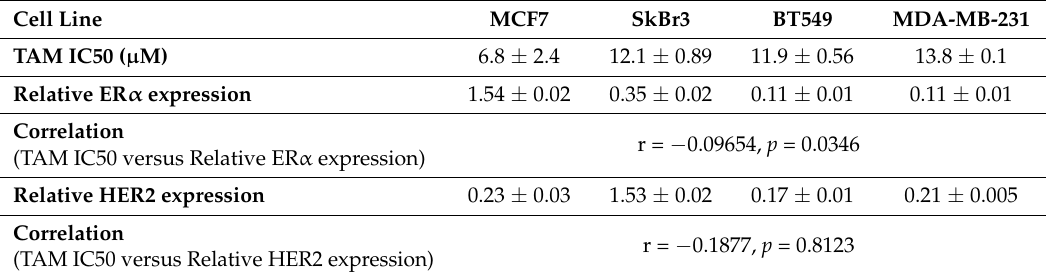
Figure 1. Differential expression of ER α and human epidermal growth factor receptor 2 (HER2/ERBB2) in breast cancer cells and their response to tamoxifen (TAM). ( A ) Western blot analysis of ER α and HER2/ERBB2 expression in MCF7, SkBr3, BT-549, and MDA-MB-231. Both proteins were visualized on the same blot. ( B ) Quantification of band intensities of the indicated proteins after normalization to β -actin. ( C ) Immunofluorescence detection of ER α in MCF7 and BT-549 (at 100 × magnification). ( D ) Immunofluorescence detection of HER2 in SkBr3 and BT-549 (at 100 × magnification). Shown are the means ± SEM of at least three independent experiments. * p < 0.05 versus MCF7 cells and # p < 0.05 versus SkBr3 cells. TNBC: triple negative breast cancer. Table 1. IC50 values of TAM, relative expression level of ER α and HER2/ERBB2 and their correlation to the sensitivity of the four cell lines to